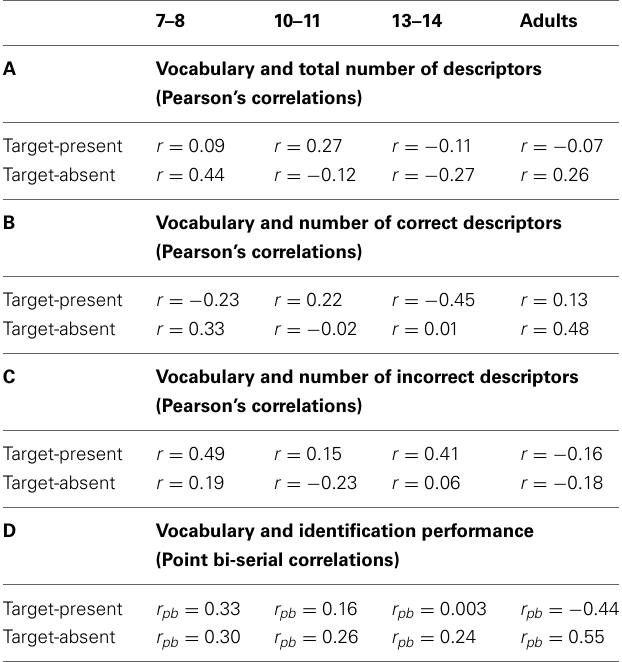
Table 4 | Correlations between performance on the vocabulary task and description quantity (A), description quality (B and C) and identification performance